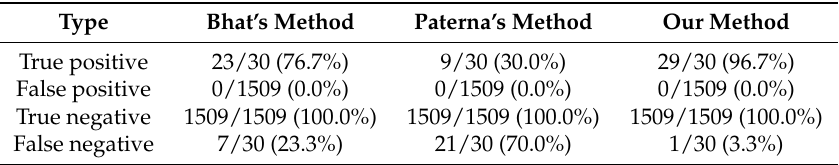
Table 1. Comparison of detection results for 30 thermal violations.